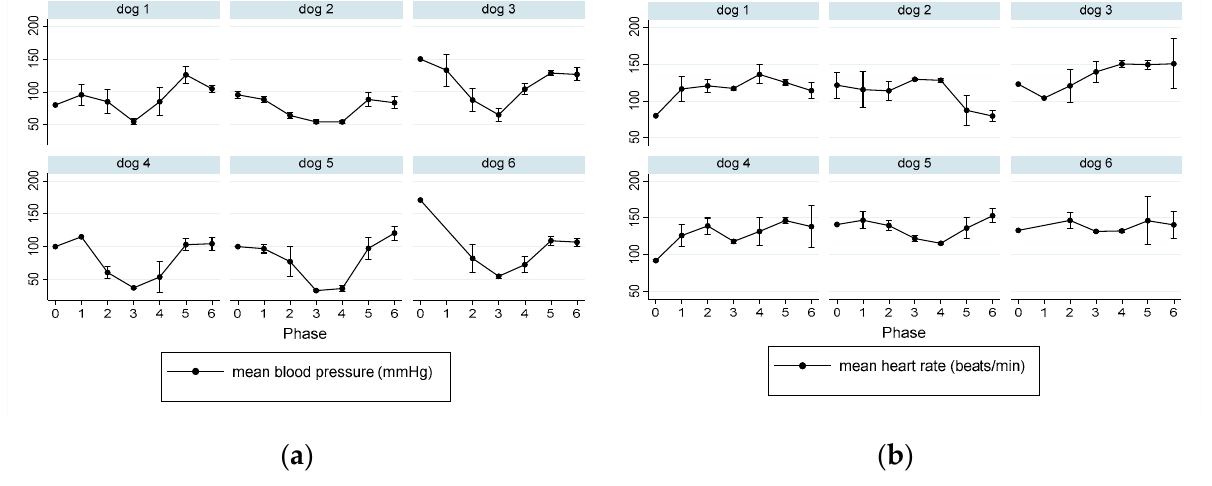
Figure 7. The individual dog’s mean blood pressure ( a ) and heart rate ( b ) responses during each phase of propofol anesthesia. For anesthesia phases, see the Figure 6 legend. The heart rate did not change significantly over the course of anesthesia, whereas mean arterial blood pressure did. However, the MBP responses to propofol between dog#5 and dog#6 were not as noticeable as those observed in EEG indices in Figure 6 between the two dogs.